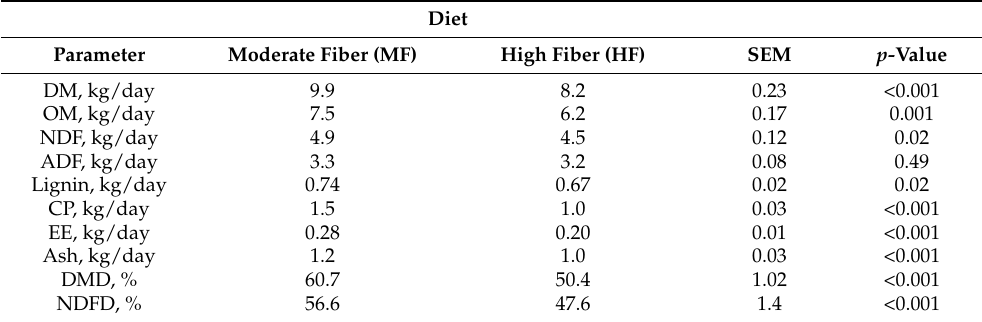
Table 3. Intake of nutritional components, apparent digestibility, and NDF of steers fed forage diets with moderate fiber content (MF) and high fiber content (HF).